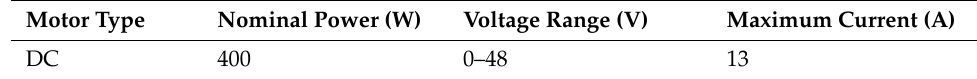
Table 4. Technical characteristics of motor pump